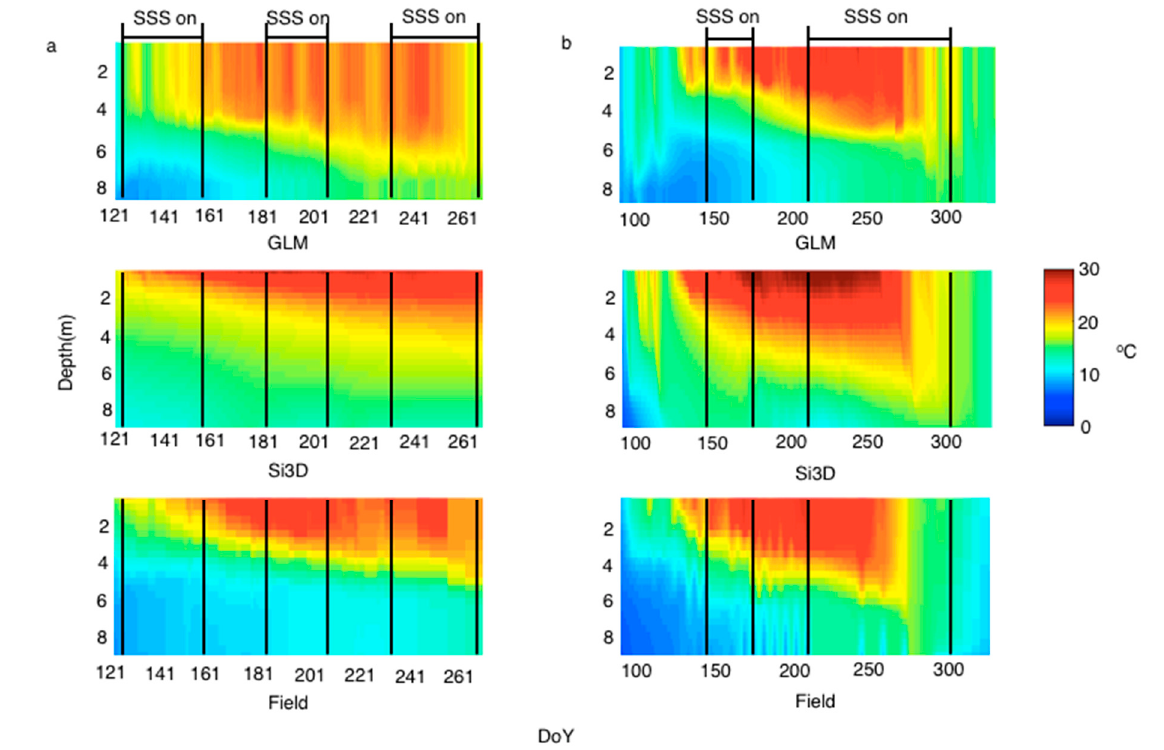
Figure 2. Comparisons of the one-dimensional (1-D, sediment module on, top row) and three dimensional (3-D) model temperature results (middle row) with field data (bottom row). ( a ) Temperature plot of 2014. ( b ) Temperature plot of 2015.